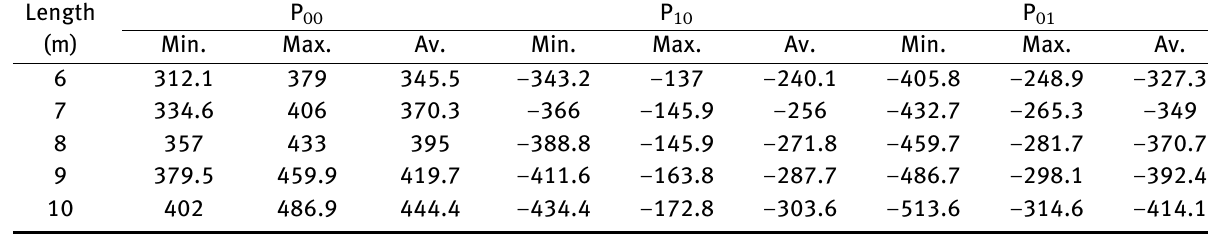
Table 5: Parameters of 1 st order polynomials used to estimate the allowable bearing capacity of piles